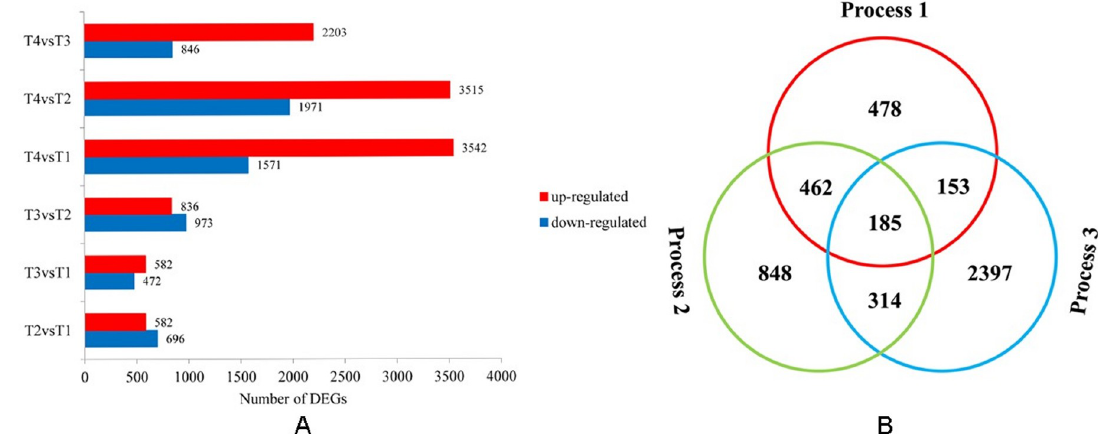
Fig 2. The distribution of differentially expressed genes. Numbers of differentially expressed genes involved in phase changes during seed dormancy release of herbaceous peony (A). Venn diagram analyses of differentially and stage-specific expression genes per comparison (B).